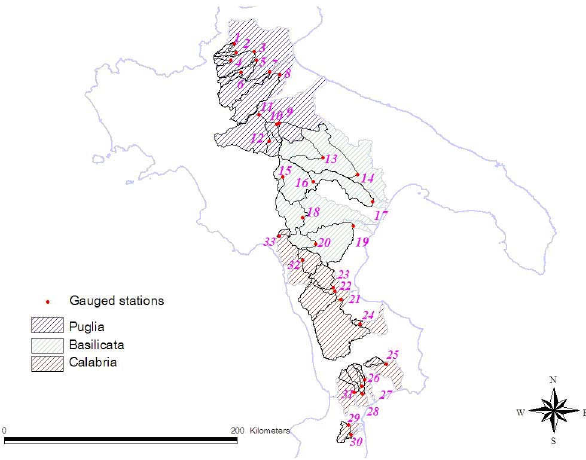
Fig. 1. Investigated basins in Southern